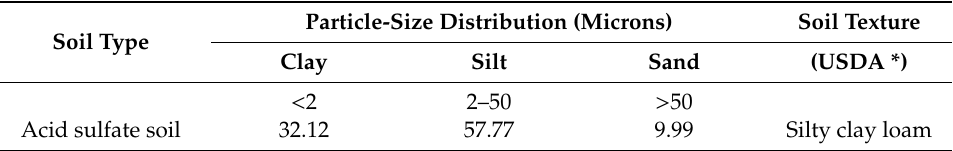
Table 1. Particle-size distribution of the soil in the experimental